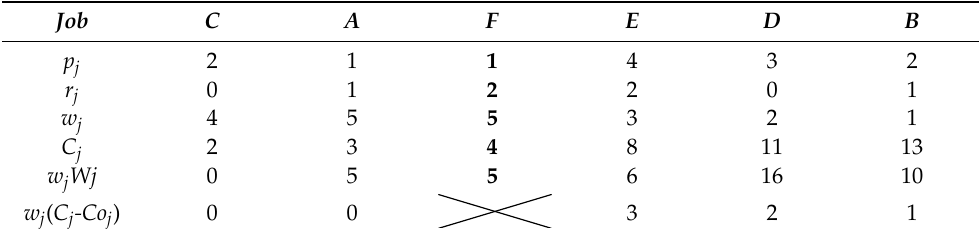
Table 5. Optimal solution after disruption caused by job G Table 4. Optimal solution after the disruption caused by job F arrival.